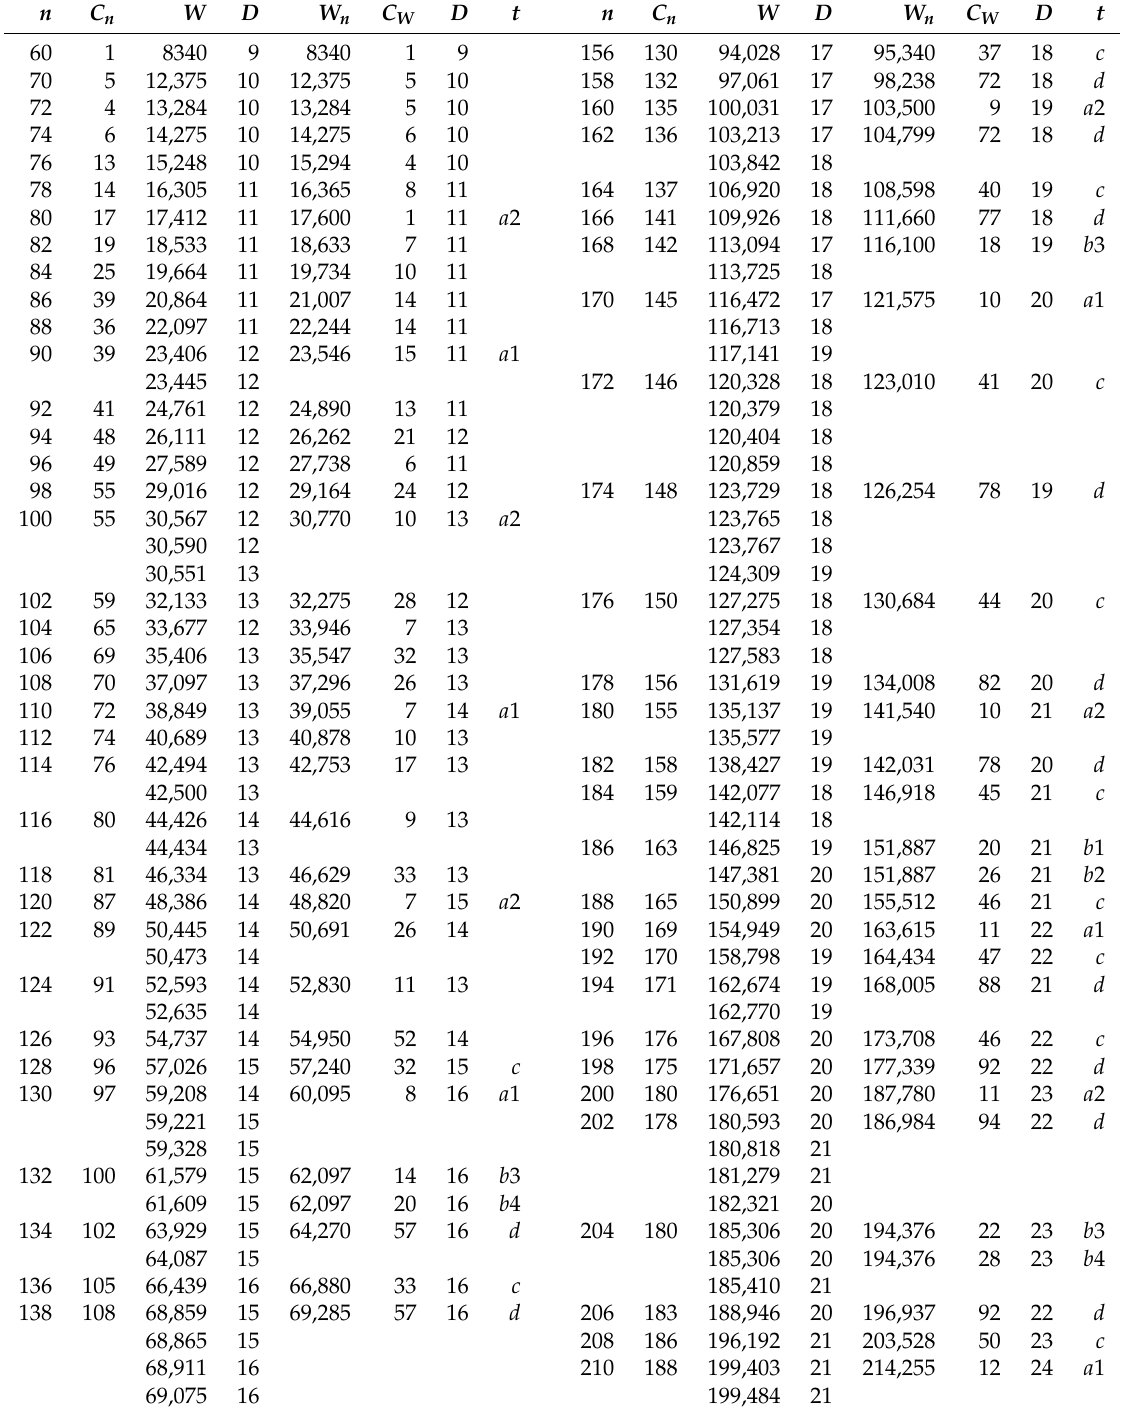
Table 2. Maximal Wiener complexity and Wiener indices of IPR fullerene